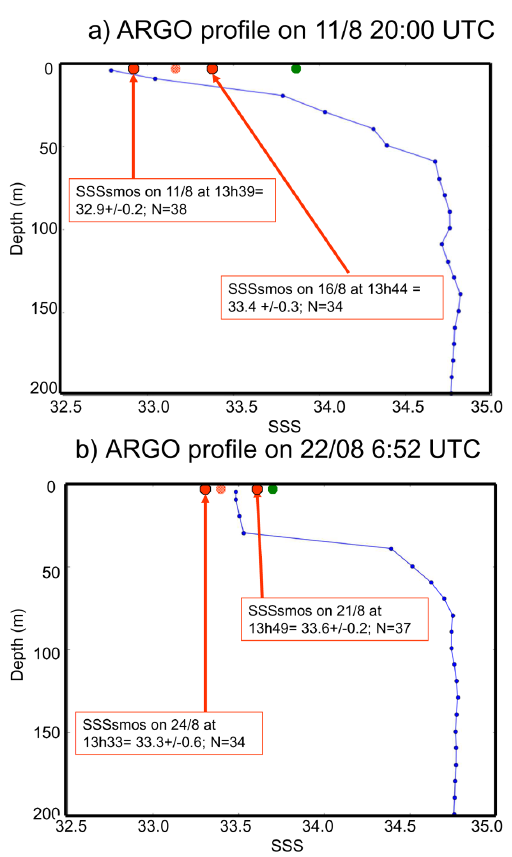
Fig. 4. Two successive ARGO profiles taken by float 4900325 (blue curve) on (a) 11 August 20:00UTC (Latitude = 12.4 ◦ N, Longi- tude = 117.6 ◦ W) and (b) 22 August 06:52UTC (Latitude: 12.2 ◦ N, Longitude: 117.8 ◦ W). Mean SMOS SSS collocated with these pro- files in a radius of 5days and 50km are indicated by a red dotted point. In each case, two SMOS passes have participated to these col- locations: mean SMOS SSS corresponding to each pass is indicated as a red filled point. The corresponding ARGO OI SSS in August is indicated by the green point. Satellite RR corresponding to these periods are indicated on Fig. 5.